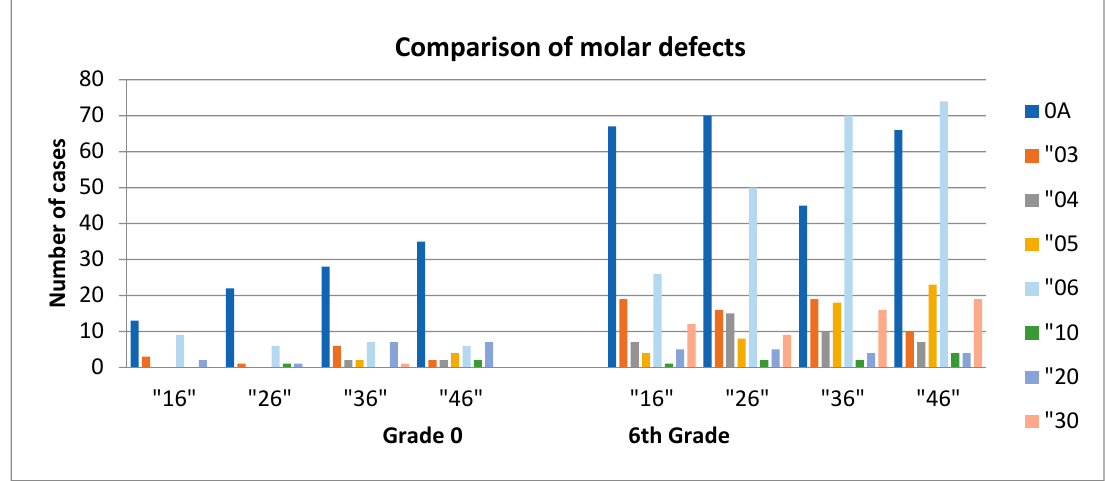
Figure 2. Comparison of ICDAS score on molar for 6 year and 12-year-old children.